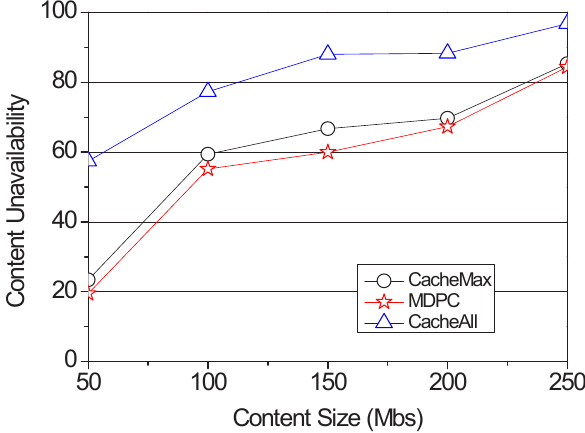
Figure 9. Caching unavailability according to the content